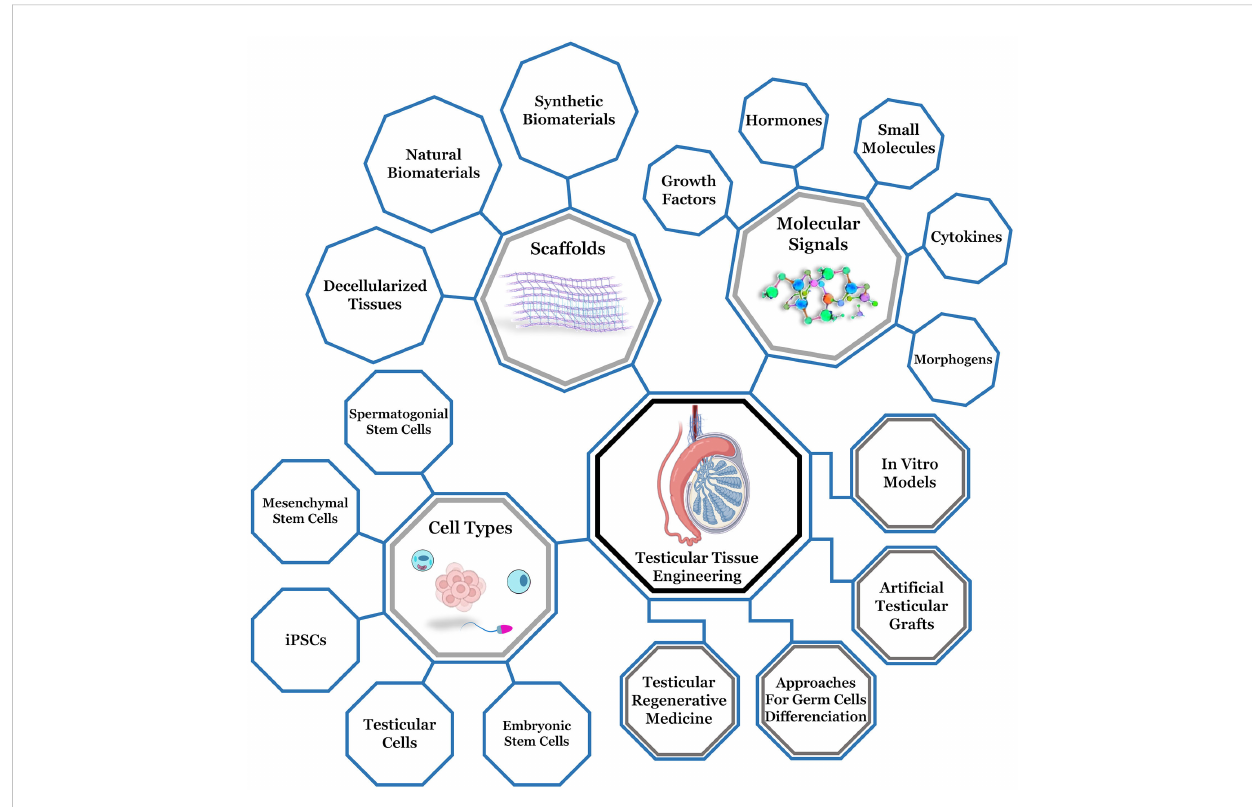
FIGURE 3 Representative diagram of testicular tissue engineering, highlighting the main components for testicular microenvironment reconstruction (biomaterials, cell types and molecular stimulation) and the main branches (testicular regenerative medicine, approaches for germ cells differentiation, development of arti fi cal testicular grafts and production of in vitro models). Adapted from